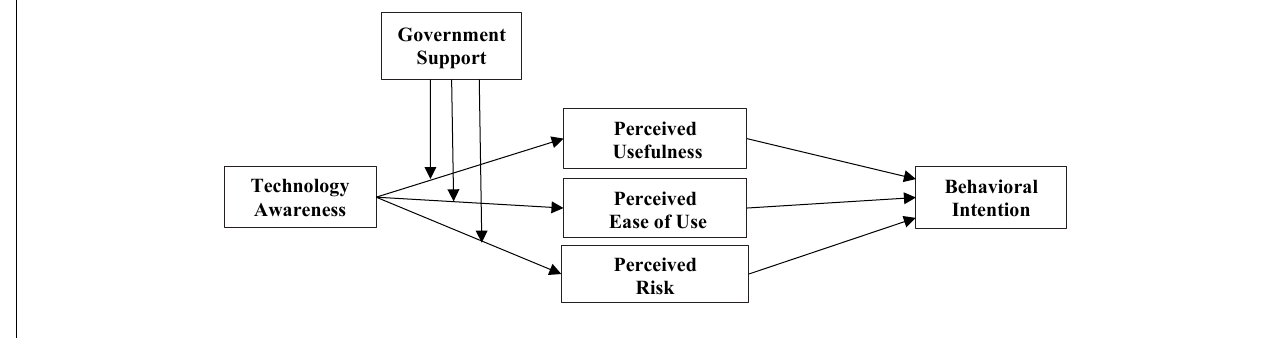
FIGURE 1 | Hypothesized